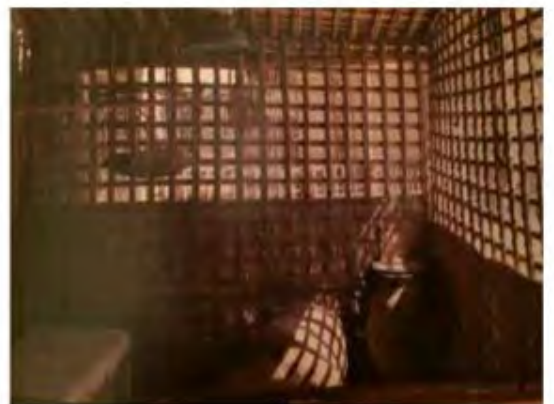
Figure 6. Date Palm Rachis walls and roofs in Arish House (Piesik, 2012)